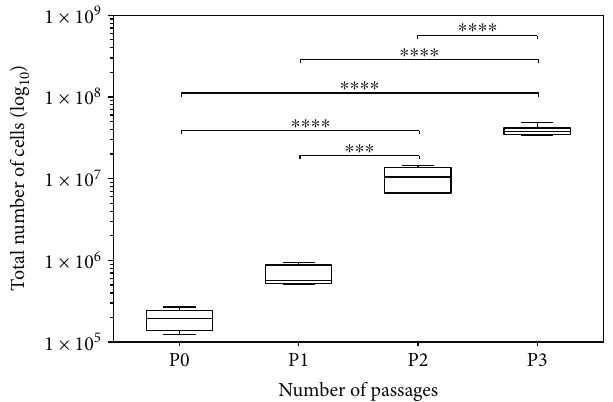
Figure 2: Total number of cells within the neurosphere cultures continuously increased signi fi cantly via passages P0-P3. Box plots show the median with the upper and lower quartiles, whiskers mark the upper and lower maximum values, and asterisks indicate the level of signi fi cance: ∗ p < 0 : 05 , ∗∗ p < 0 : 005 , ∗∗∗ p < 0 : 001 , and ∗∗∗∗ p < 0 : 0001